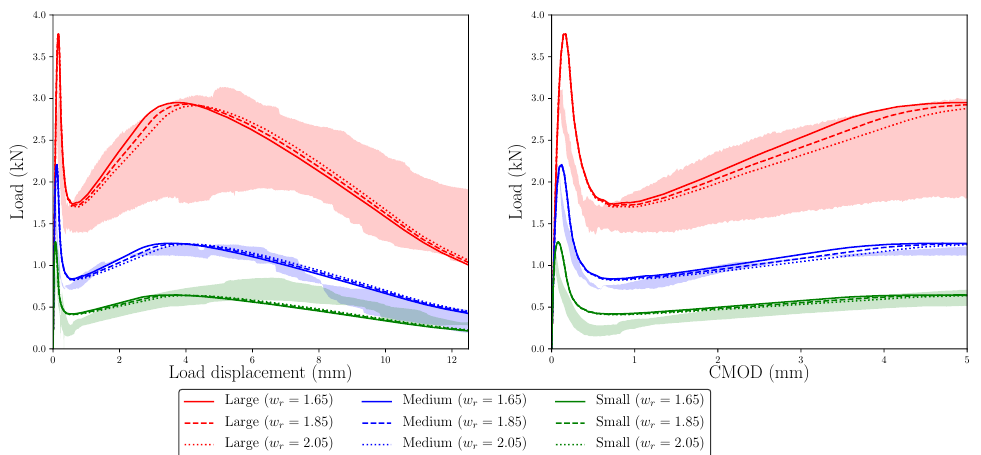
Figure 10. Numerical results compared with the experimental envelopes to study the influence of w r on the numerical simulations. The trilinear functions used in each case are shown in Figure 9. Experimental envelopes correspond to three specimens